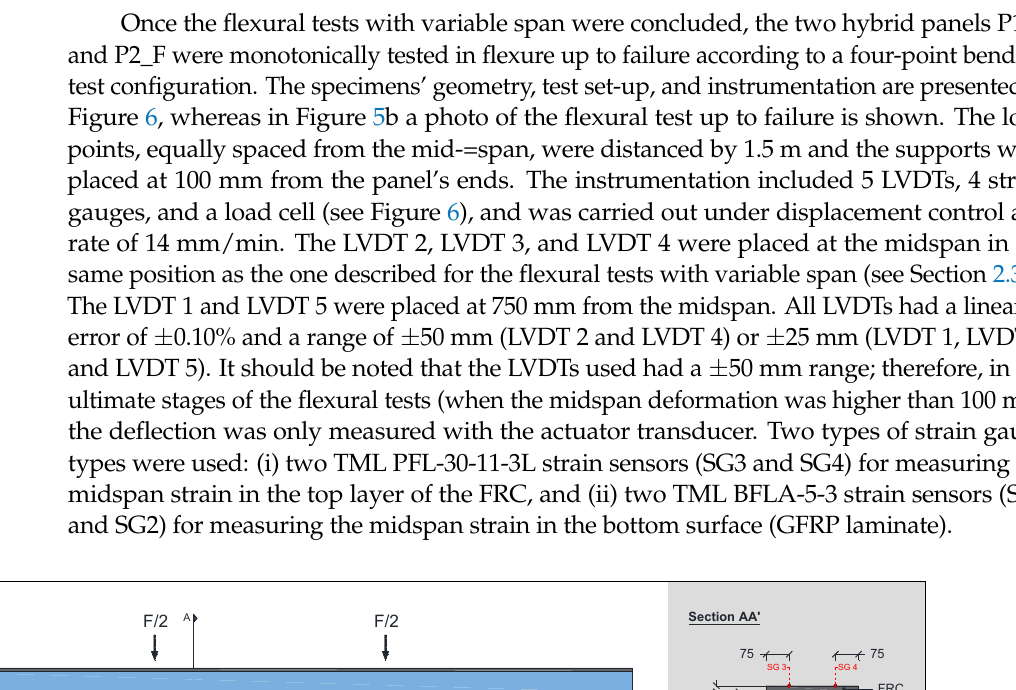
Figure 5. Photo of test set-up for ( a ) static flexural test with variable span and ( b ) flexural failure tests.